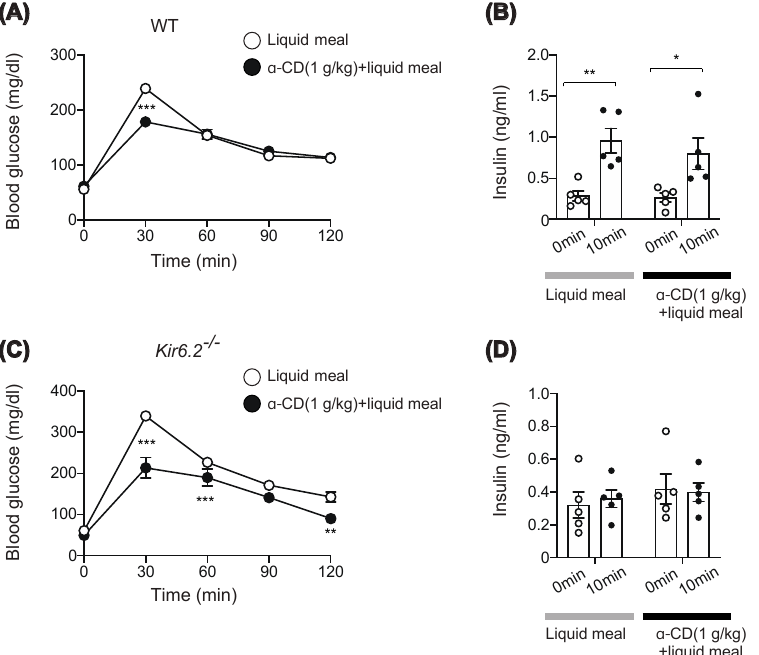
Figure 3. Effect of 1 g/kg α‐ CD on blood glucose and plasma insulin levels during MTT. ( A , C ) Blood glucose levels during MTT using liquid meal (10 μ L/g) supplemented with or without α‐ CD (1 g/kg) in WT ( A ) ( n = 8) and Kir6.2 − / − mice ( C ) ( n = 9). ( B , D ) Plasma insulin levels before and at 10 min during MTT in WT ( B ) ( n = 5) and Kir6.2 − / − mice ( D ) ( n = 5). Bars depict mean ± SEM. Each data is plotted as a circle. * p <0.05, ** p < 0.01, and *** p < 0.001 by unpaired ‐ Student t ‐ test.